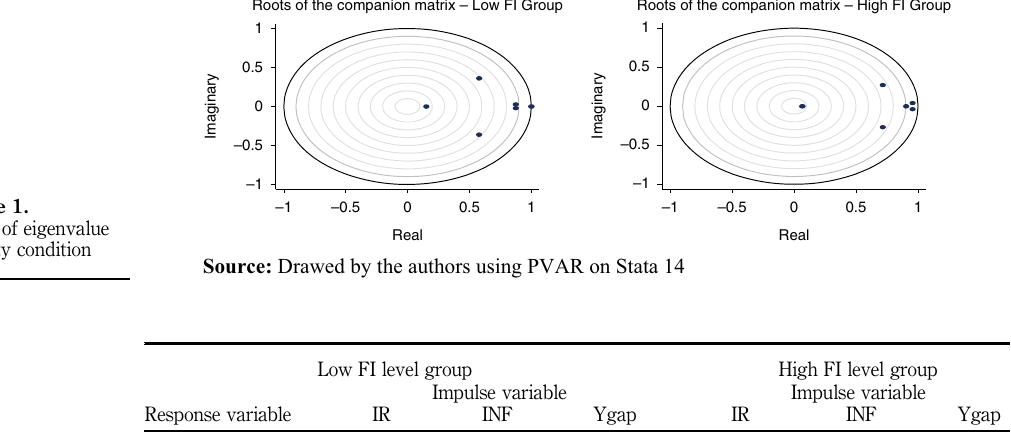
Table VII. Variance decomposition